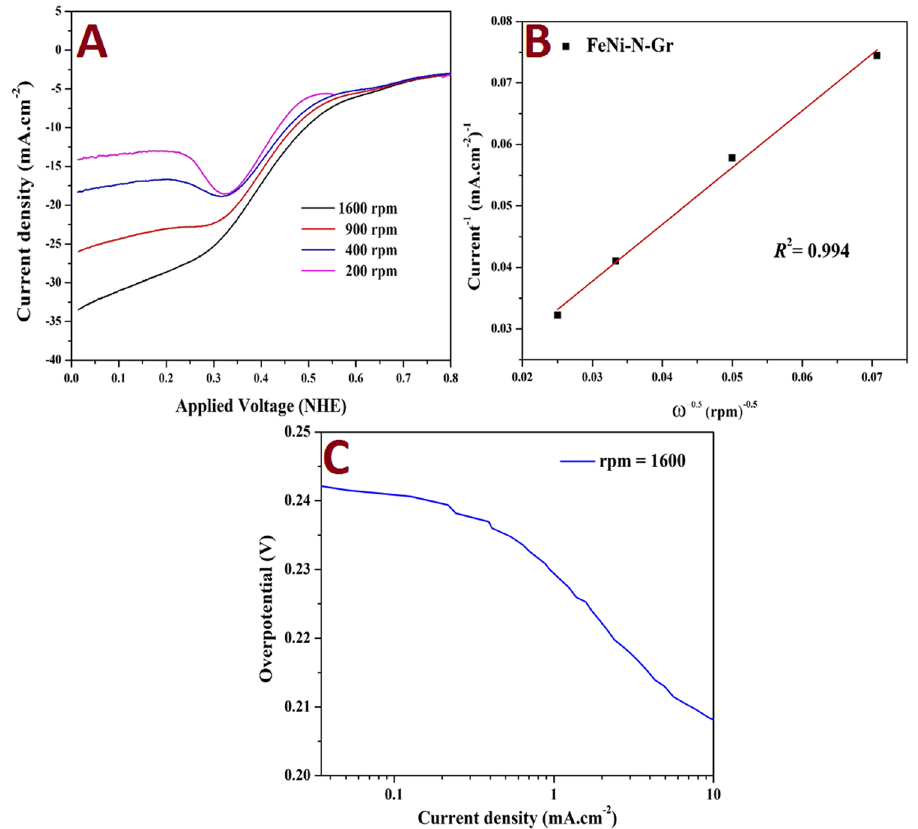
Figure 8. Polarization curve for the oxygen reduction reaction over the introduced FeNi-N-Gr in oxygen- saturated 0.5 H 2 SO 4 at different rotating rates and sweeping rate 5 mV s − 1 ; ( A ) Koutechý-Levich plots for oxygen reduction at 0.1 V (vs. NHE); ( B ) Tafel plot at 1600 rpm ( C